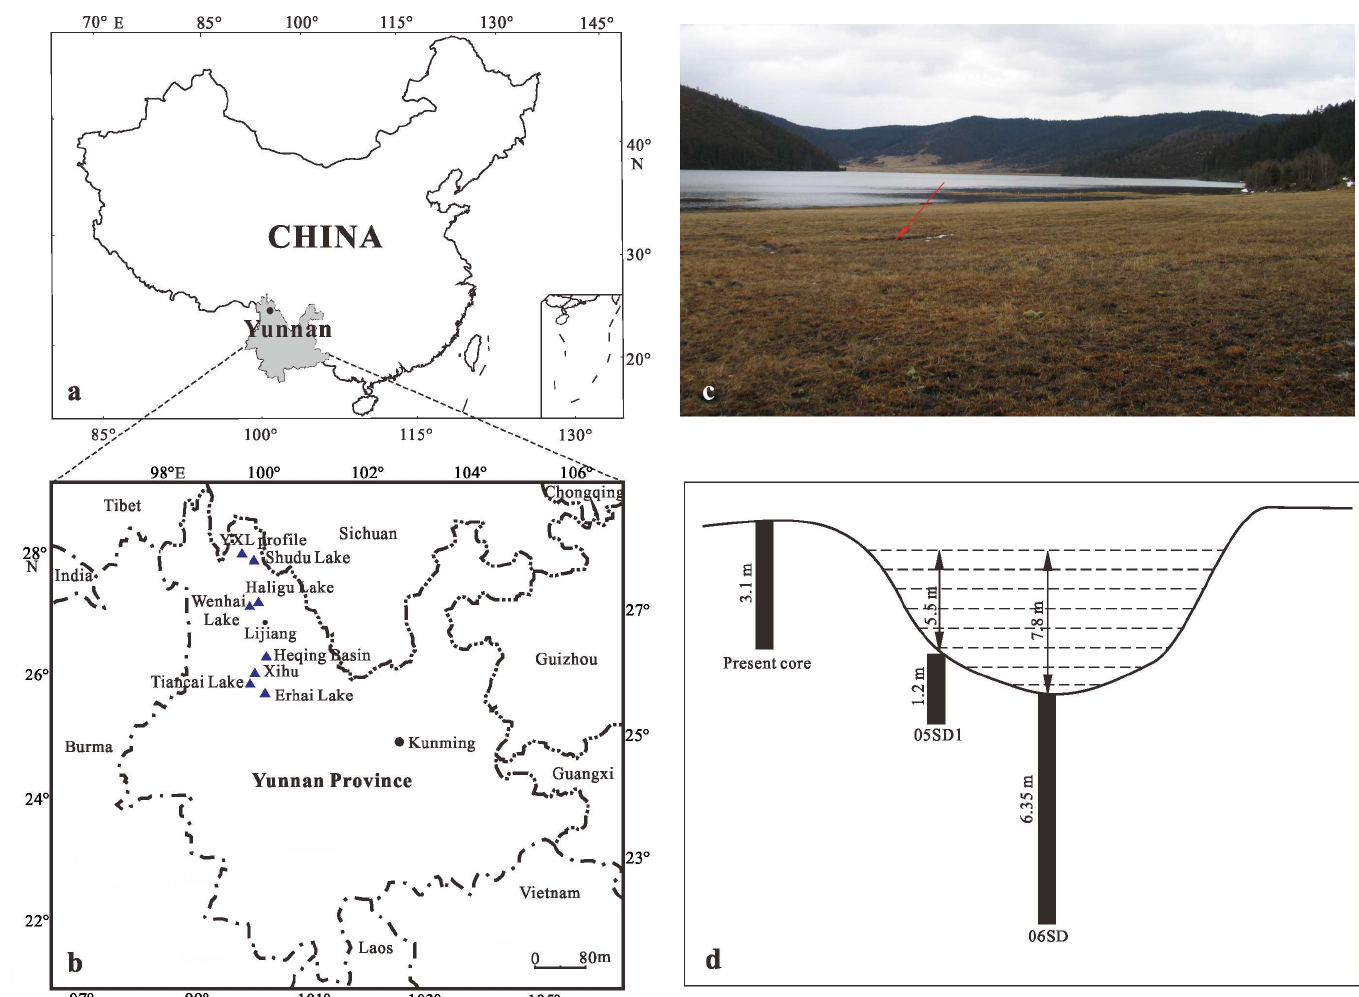
Fig 1. a. Locationof Yunnanin China, b. Location of Shudu Lake and other studiedsites in northwestern Yunnan, c. Panoramic view of Shudu Lake (red arrow represents position of core), d. Position of present and previousstudied cores at Shudu